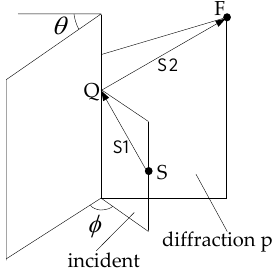
Figure 3. Schematic diagram of straight edge diffraction geometry.